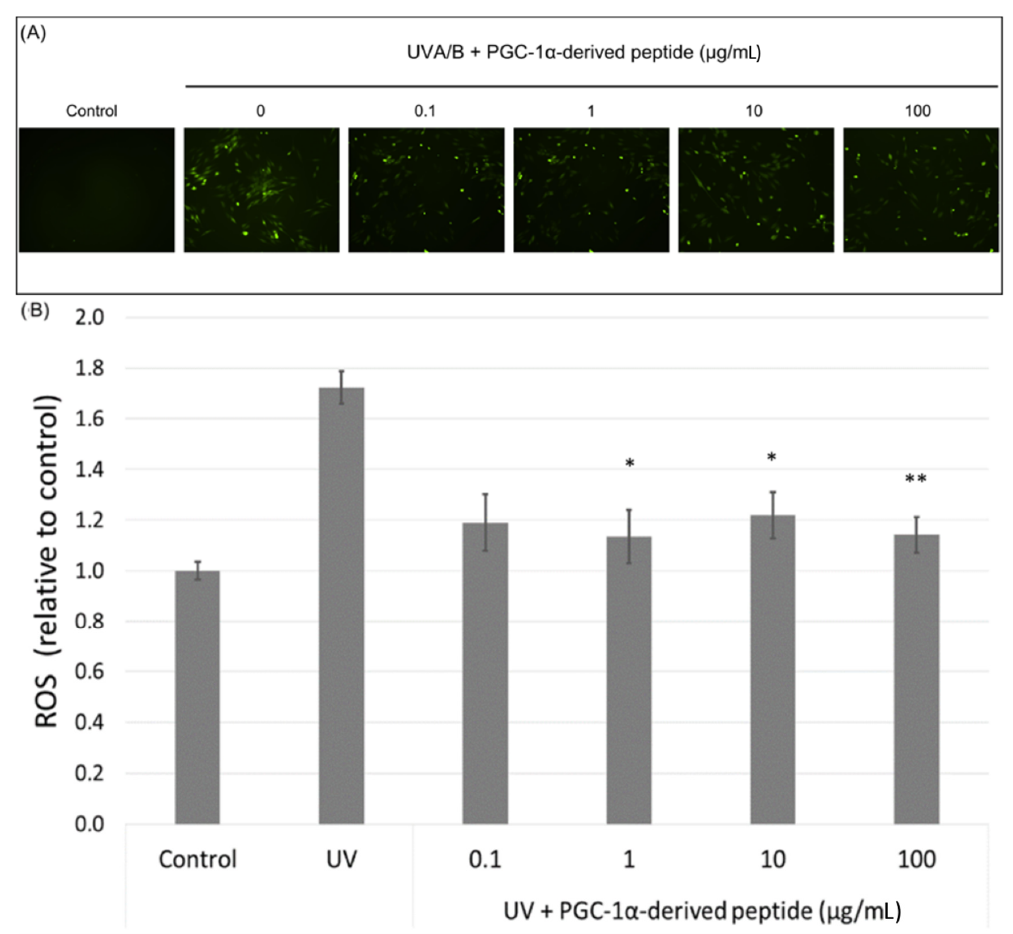
Figure 6. The reactive oxygen species (ROS) level in NHDF cells. Cultured cells were irradiated with UVA/B at a dose of 0.15 J/cm 2 and then treated with the PGC-1 α -derived peptide at various concentrations for 1 h. The ROS level was determined using DCFH-DA dye with a fluorescent microscope ( A ) and a fluorescence reader ( B ). Values represent means ± SEM of at least 3 independent experiments (* p < 0.05, ** p < 0.01 compared with UV irradiated group).